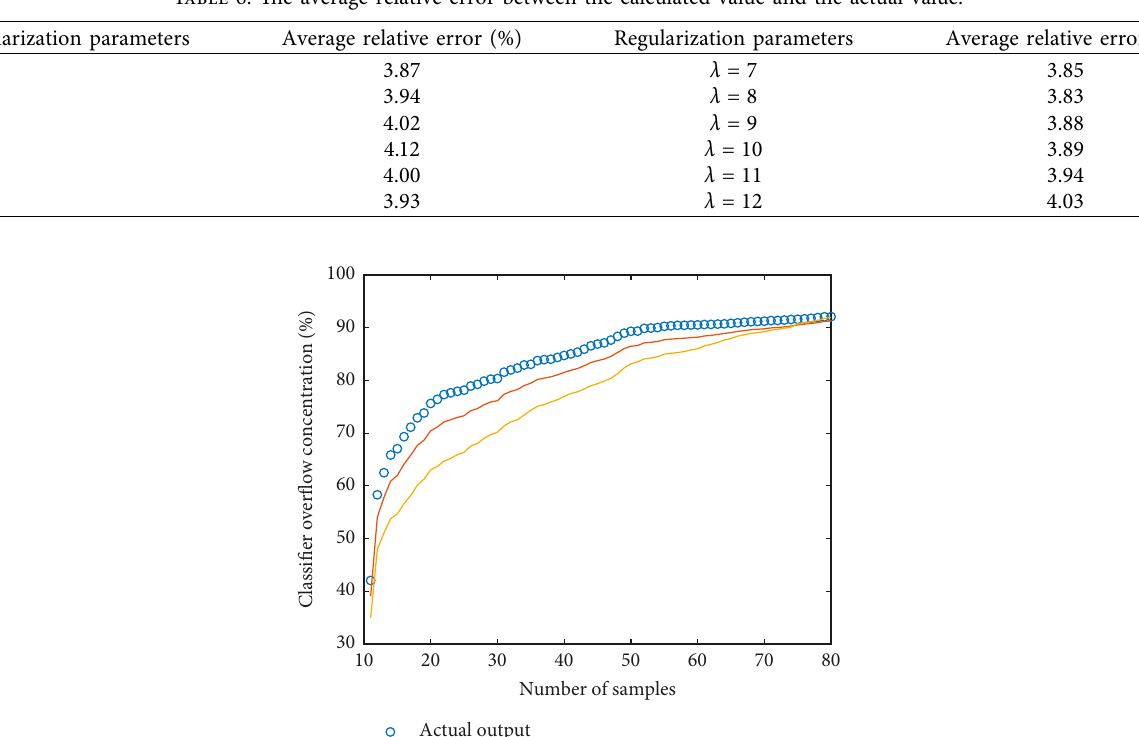
Table 6: The average relative error between the calculated value and the actual value.